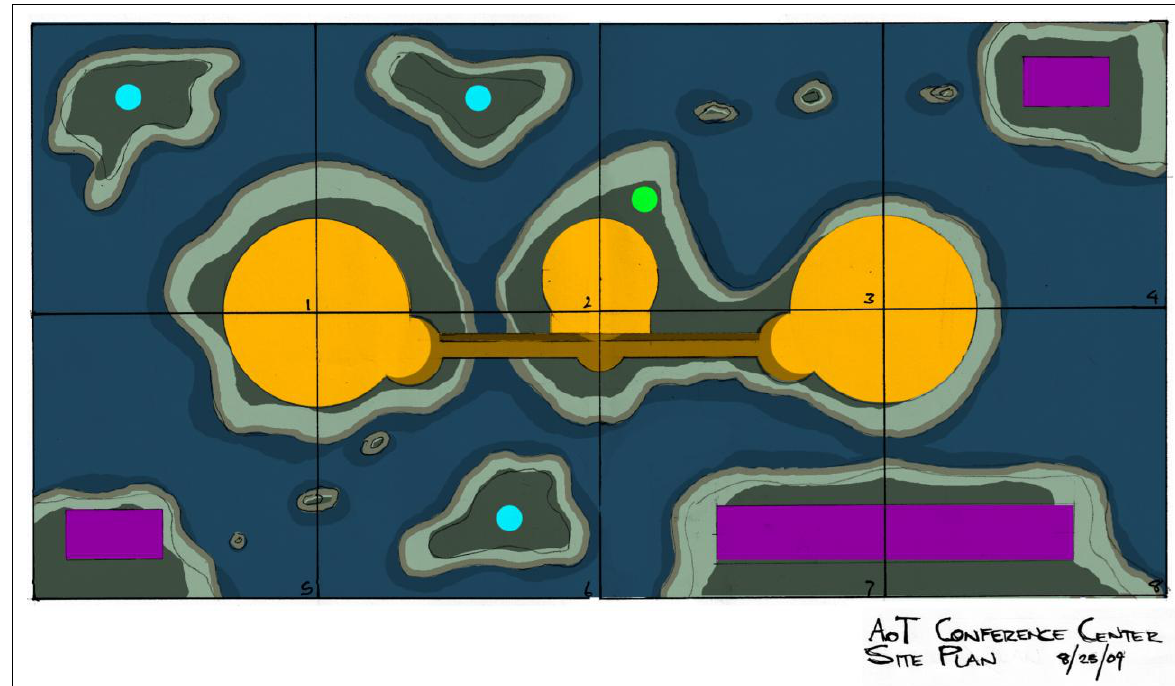
Figure 5. AGM 2009 “Waterworld” Master Plan.